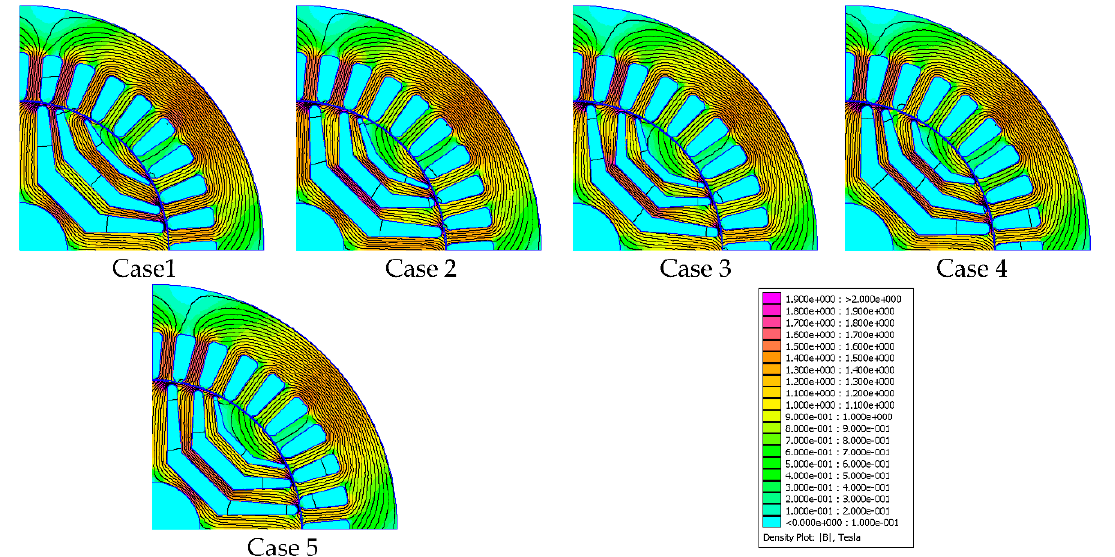
Figure 13. Flux density distribution of the optimal geometry for different cases.